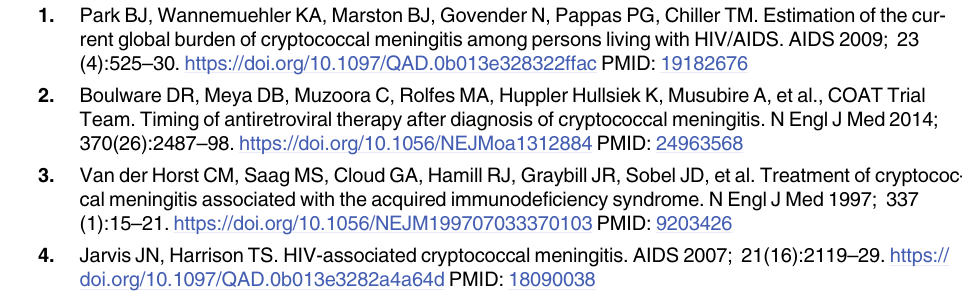
S1 Fig. Relationship between baseline fungal burden and CSF cryptococcal antigen titer. S2 Fig. Relationship between baseline fungal burden and baseline CSF opening pressure. S3 Fig. Relationship between baseline fungal burden and Cryptococcus sp. growth